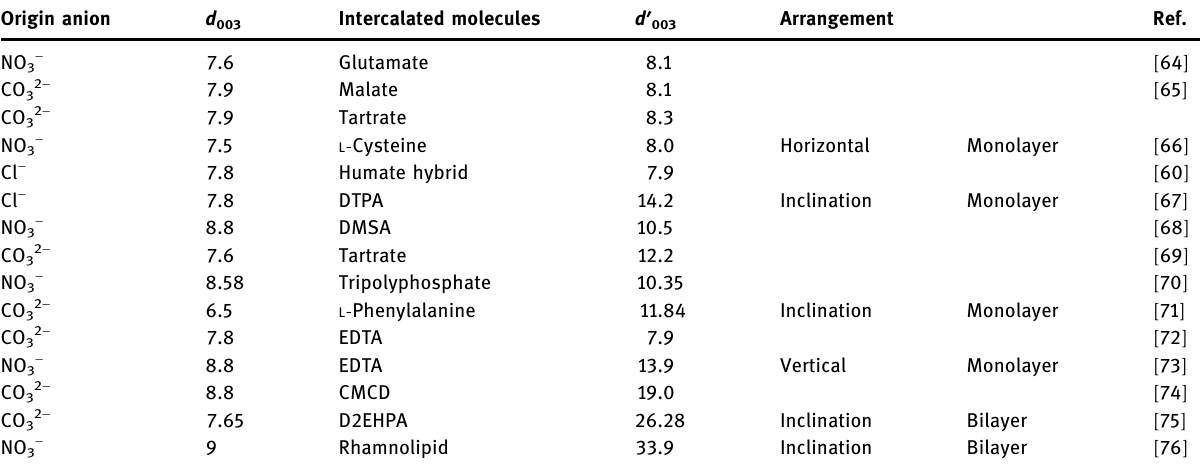
Table 4: The basal spacing ( Å ) of LDH and arrangement of molecules Origin anion d 003